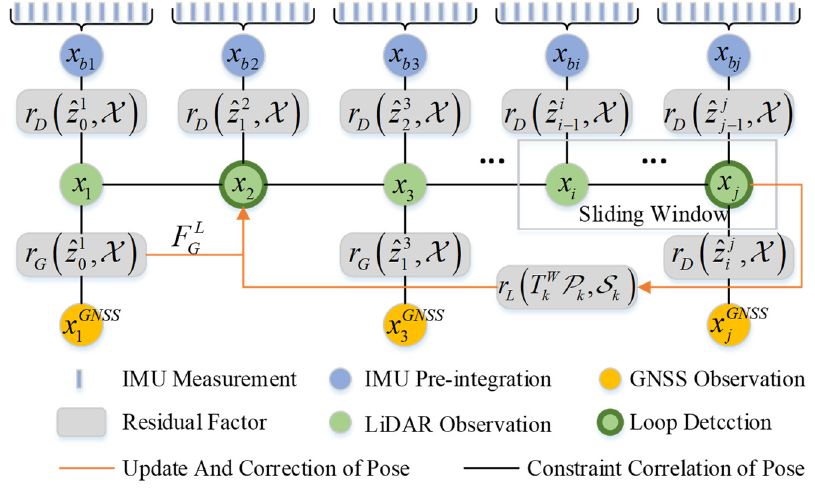
Figure 6. LiDAR-IMU-GNSS fusion framework based on graph optimization.